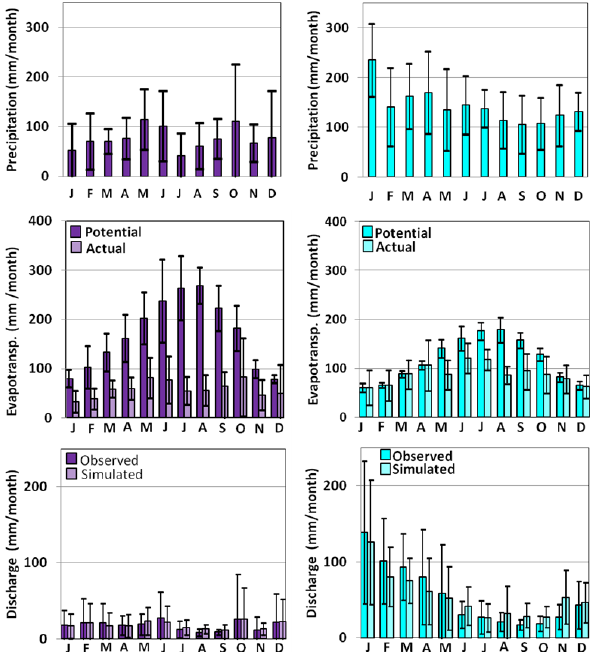
Figure 8 : Significant (p<0.05; * indicates p<0.01) linear regression relationships between catchment characteristics (minimum and maximum LAI, mean elevation and mean catchment slope) and different model parameters for 6 no-snow dominated catchments.